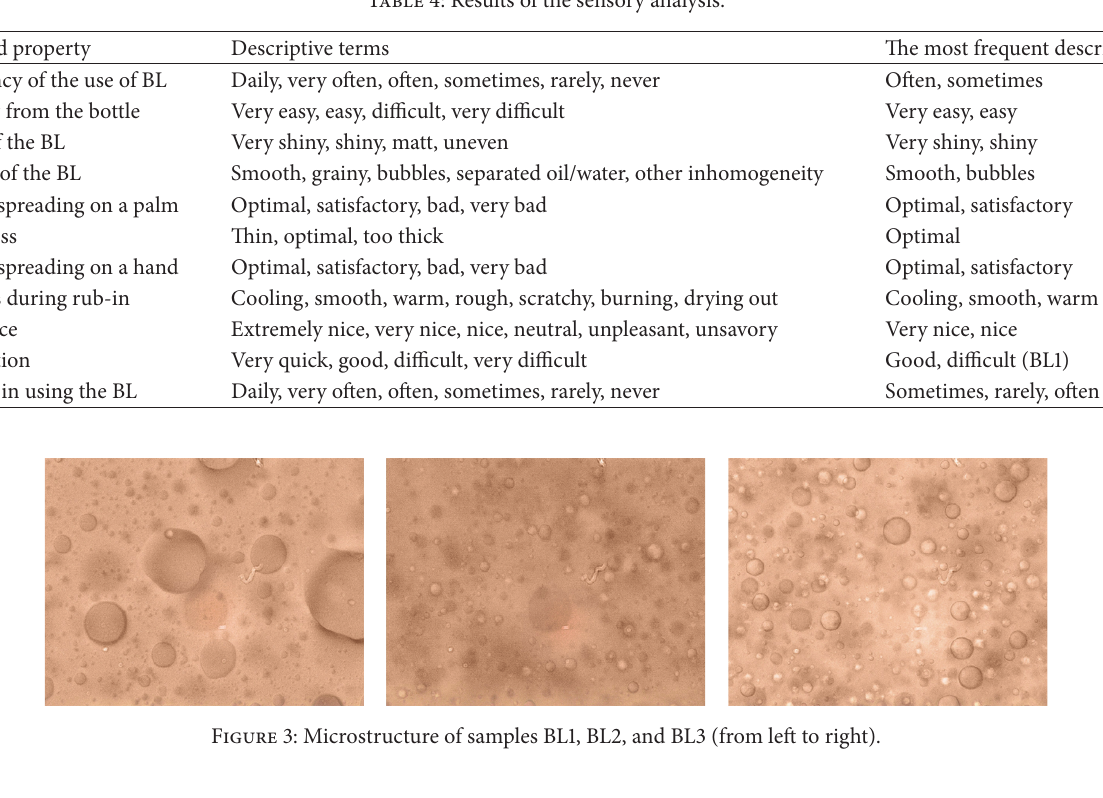
Table 4: Results of the sensory analysis.